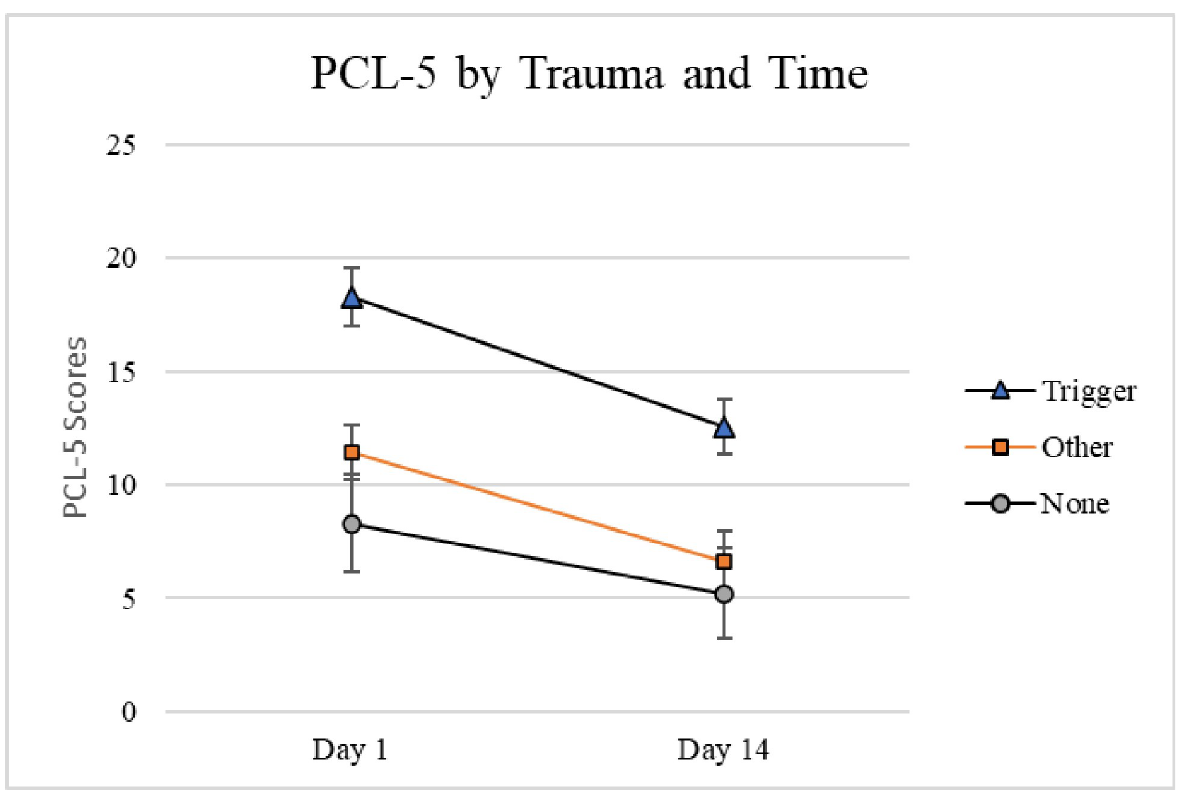
Fig 3. PCL scores at Day 1 and Day 14 as a function of trauma. Average PTSD checklist scores shown with standard error bars as a function of day and trauma type (Trigger, n = 95; Other, n = 107; None, n = 34).